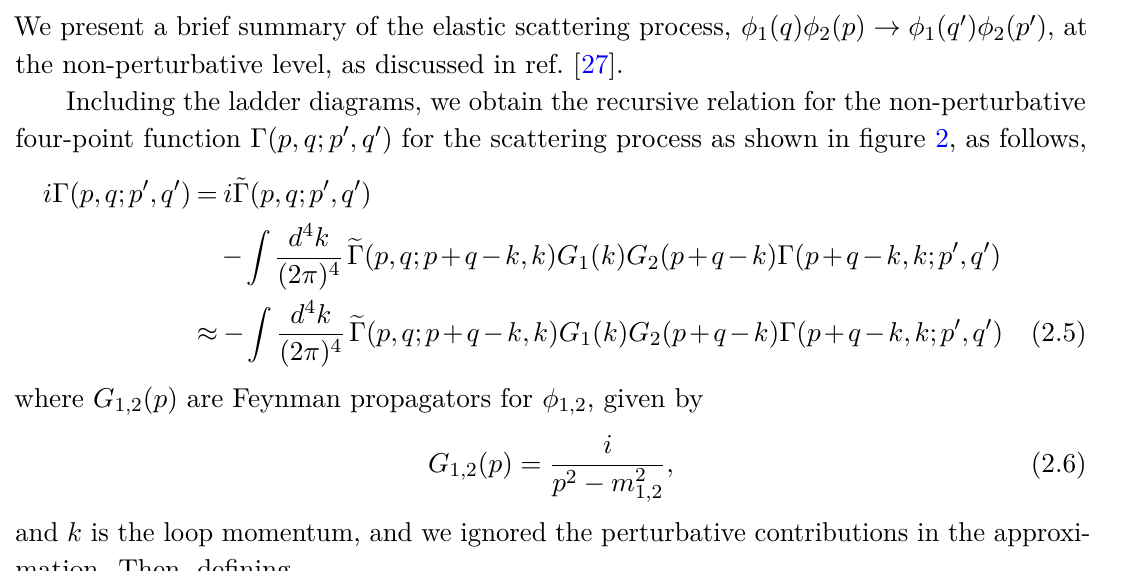
φ 1 φ 2 at non-perturbative →